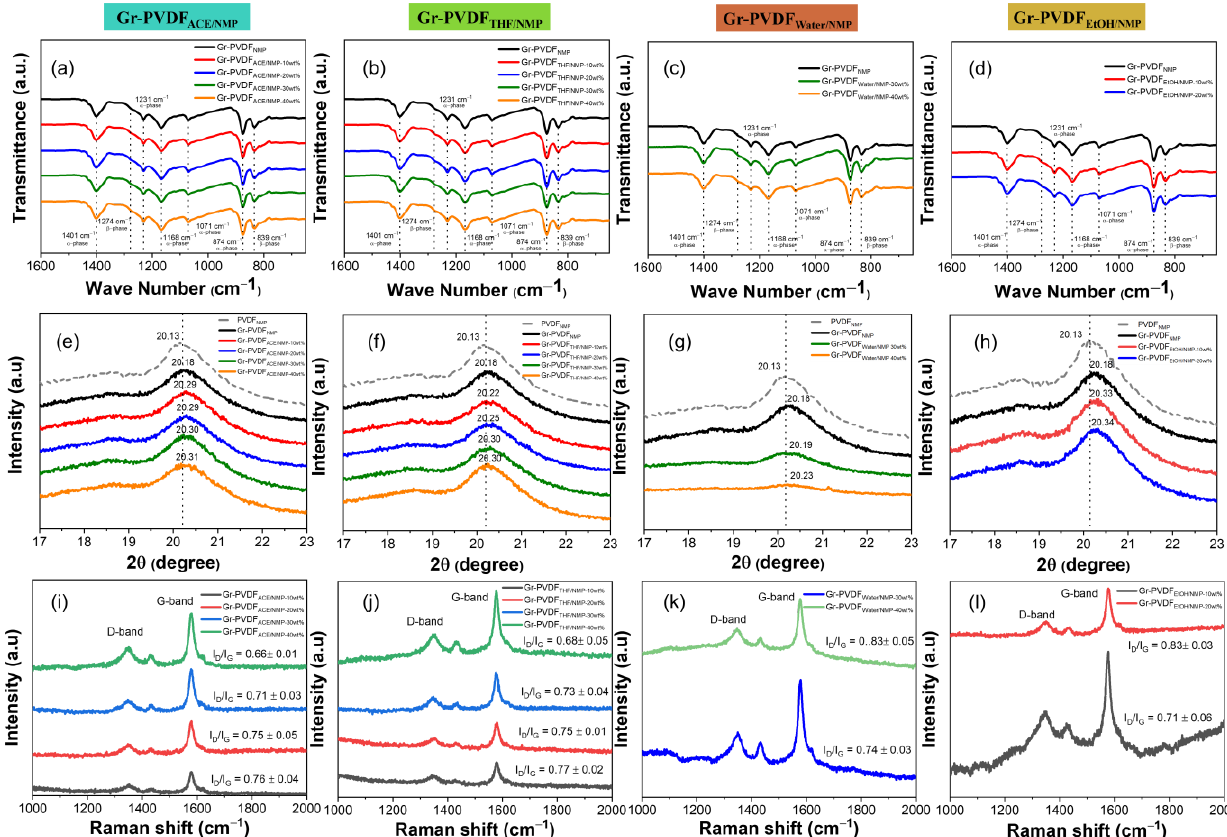
Figure 6. ( a – d ) FTIR-ATR spectra, ( e – h ) X-Ray diffraction, ( i – l ) Raman spectroscopy of the PVDF composite film’s top surface after it was made with several co-solvents.